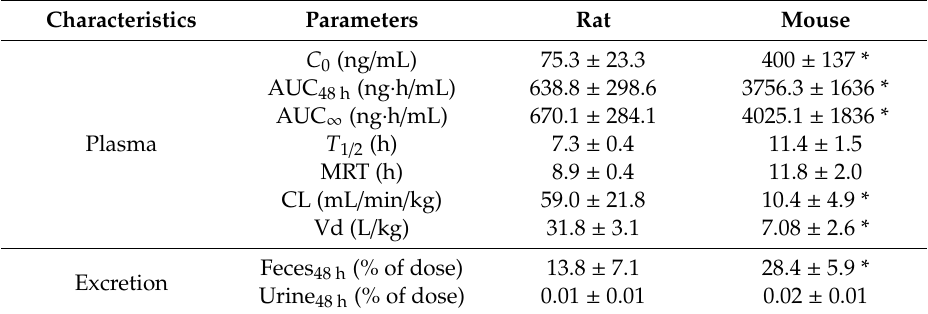
Figure 1. ( A ) Plasma concentration vs. time profile of compound K following intravenous injection of compound K at a single dose of 2 mg/kg in rats ( A ) and mice ( B ). Plasma concentration of compound K ( Y -axis) was represented using a logarithmic scale. Data expressed as mean± standard deviation from four rats or four mice at different time points. Table 3. Pharmacokinetic parameters of compound K in rat and mouse.